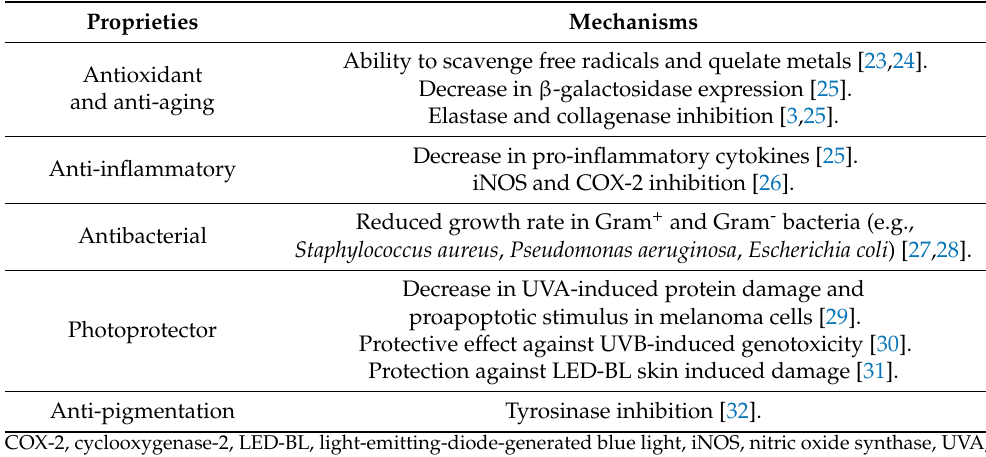
Table 1. Hydroxytyrosol skin-related benefits documented in scientific literature. Proprieties Mechanisms Ability to scavenge free radicals and quelate metals [23,24]. Antioxidant Decrease in β -galactosidase expression [25]. and anti-aging Elastase and collagenase inhibition [3,25]. Decrease in pro-inflammatory cytokines [25]. Anti-inflammatory iNOS and COX-2 inhibition [26]. Reduced growth rate in Gram + and Gram - bacteria (e.g., Antibacterial Staphylococcus aureus , Pseudomonas aeruginosa , Escherichia coli ) [27,28]. Decrease in UVA-induced protein damage and proapoptotic stimulus in melanoma cells [29]. Photoprotector Protective effect against UVB-induced genotoxicity [30]. Protection against LED-BL skin induced damage [31]. Anti-pigmentation Tyrosinase inhibition